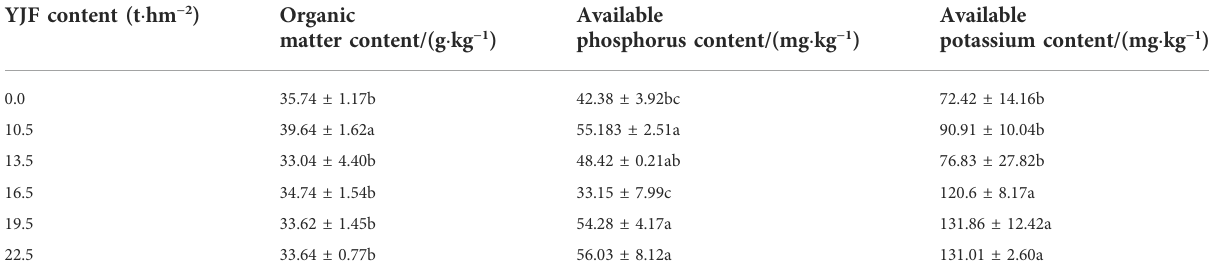
Different letters in the same column indicate signi fi cant differences ( p < 0.05) based on a post-hoc test (Waller-Duncan k-ratio test).